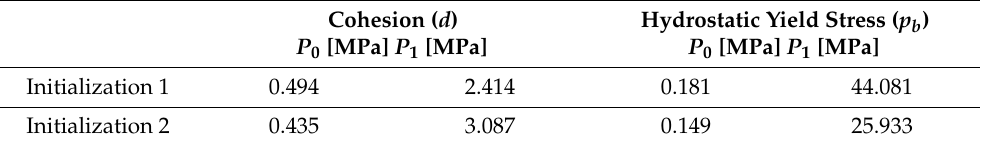
Table 1. Selected parameter values assessed through inverse analysis procedure based only on force–displacement curve from compaction of cylindrical green body.